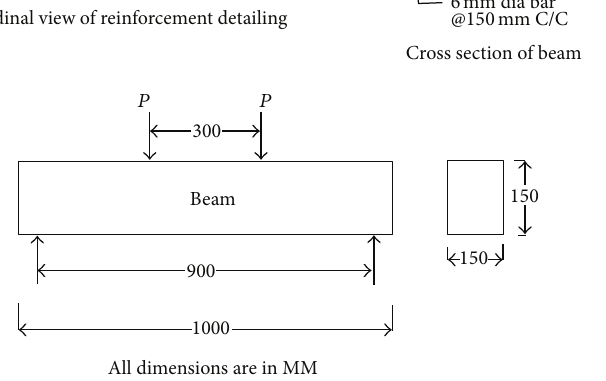
Figure 1: Beam in